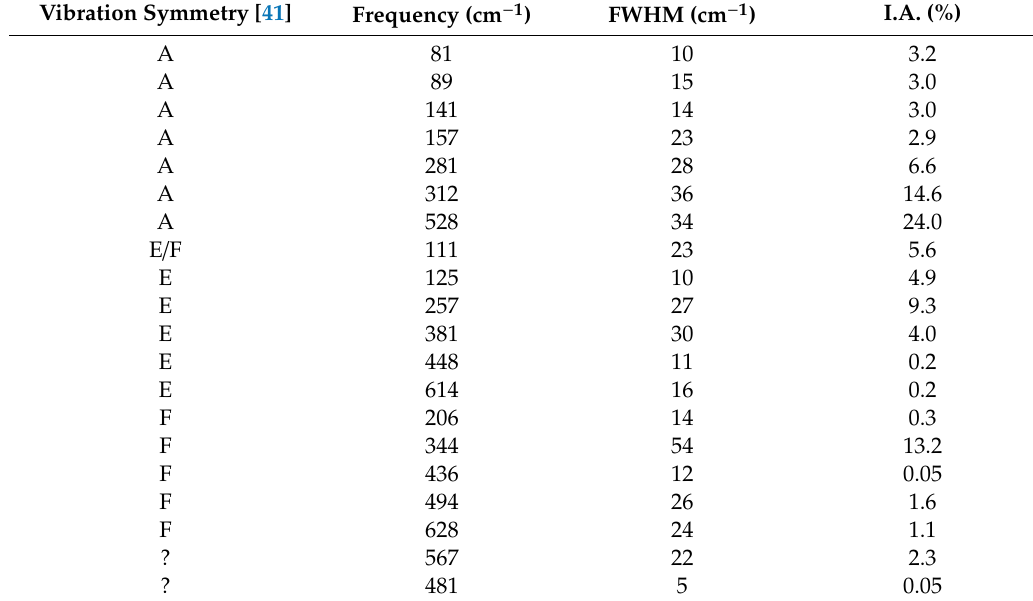
Table 2. Summary of deconvoluted Raman spectra of γ –Bi 2 O 3